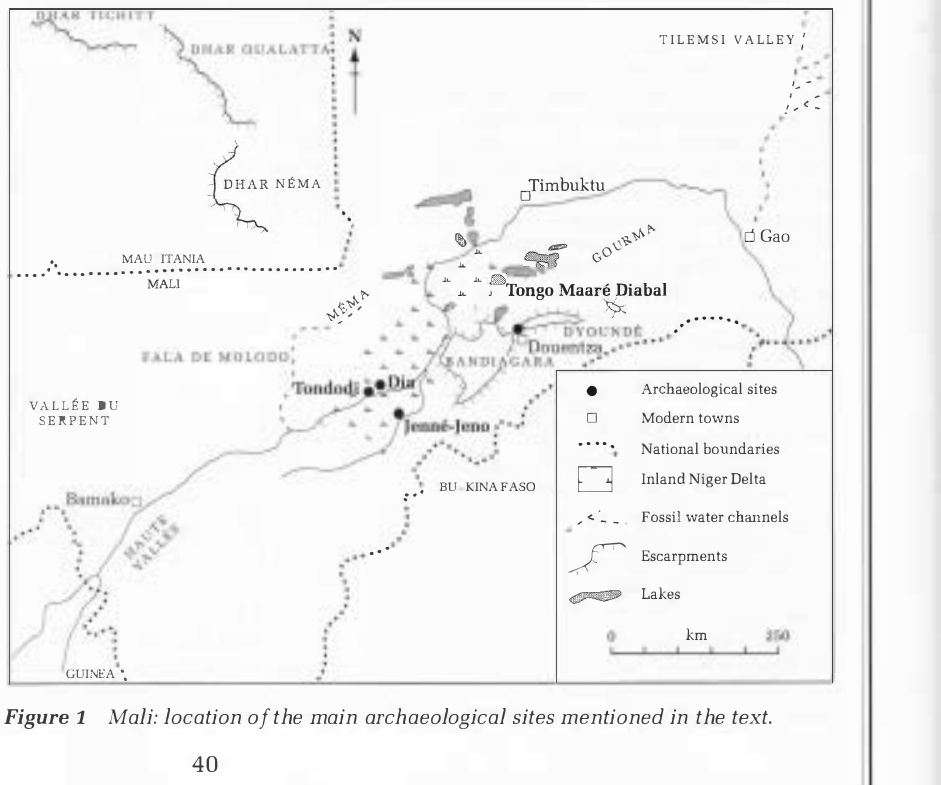
Figure 1 Mali: location of the main archaeological sites mentioned in the